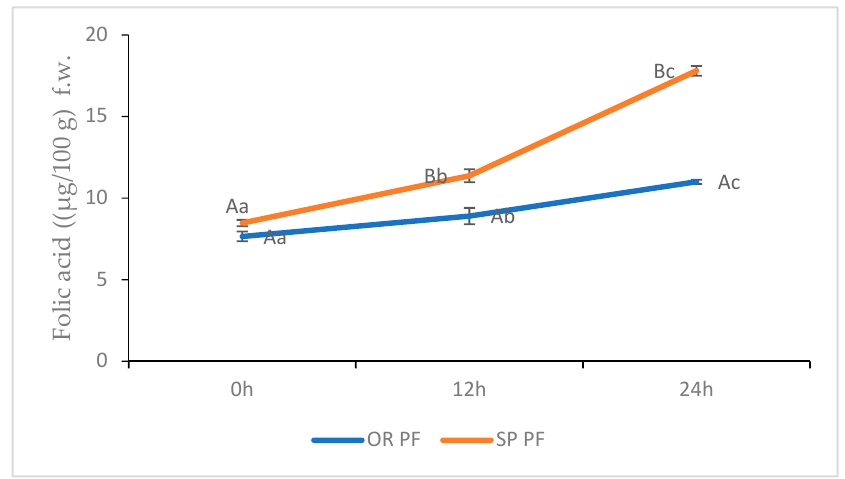
Figure 8. Folic acid content of gluten free muffins. Small letters in common indicate no significant differences between OR and SP samples withdrawn at different moments; Big different letters indicate significant differences between SP and OR samples withdrawn at the same moment .